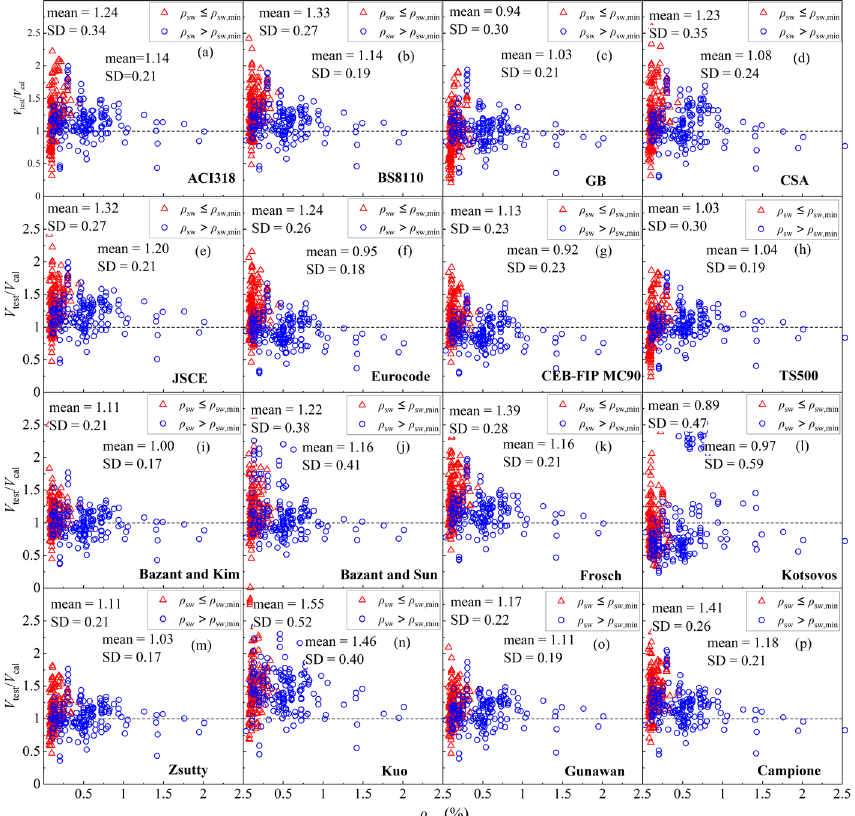
Figure 15. The relationship between the ratios ( V test / V ca l ) and stirrup ratio of ( a ) ACI318; ( b ) BS8110;